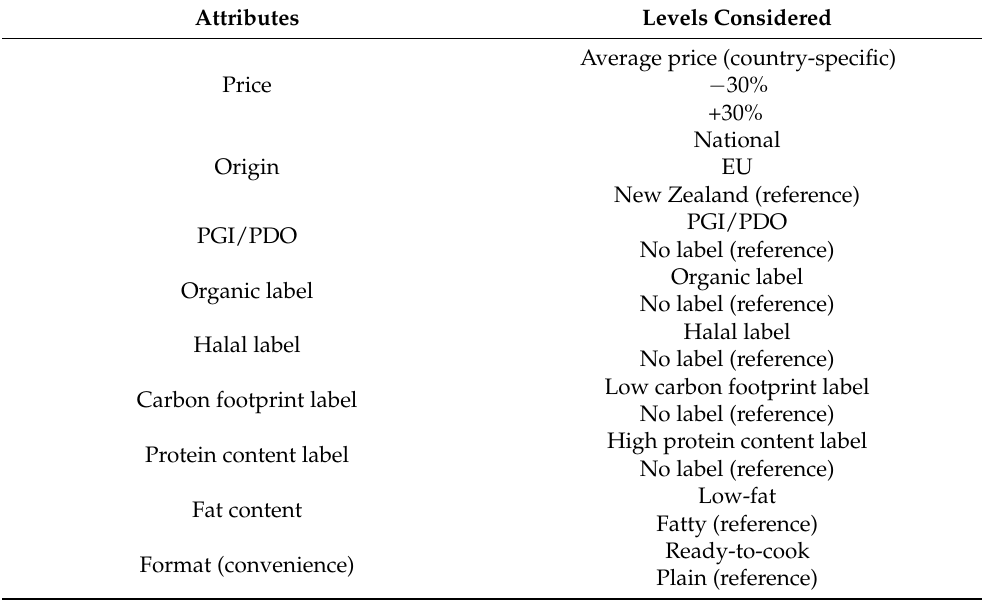
Table 1. Attribute levels. Attributes Levels